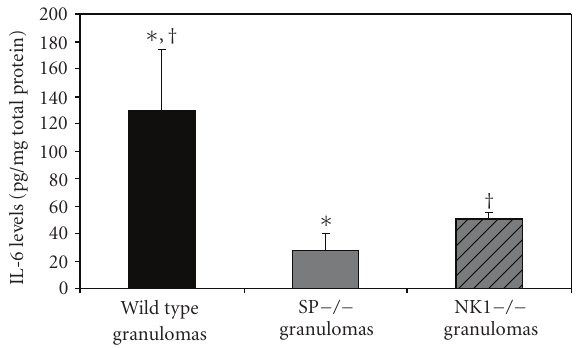
Figure 4: Quantitative levels of IL-6 in granulomas derived from Taenia crassiceps infected, WT ( n = 12), SPP-knockout mice ( n = 6), and NK1-knockout mice ( n = 9). Data presented are mean ± SEM; ∗ P < 05, IL-6 levels in infected, SPP-knockout derived granulomas versus WT derived granulomas, † P < . 05, IL- 6 levels in infected, NK1-knockout derived granulomas versus WT derived